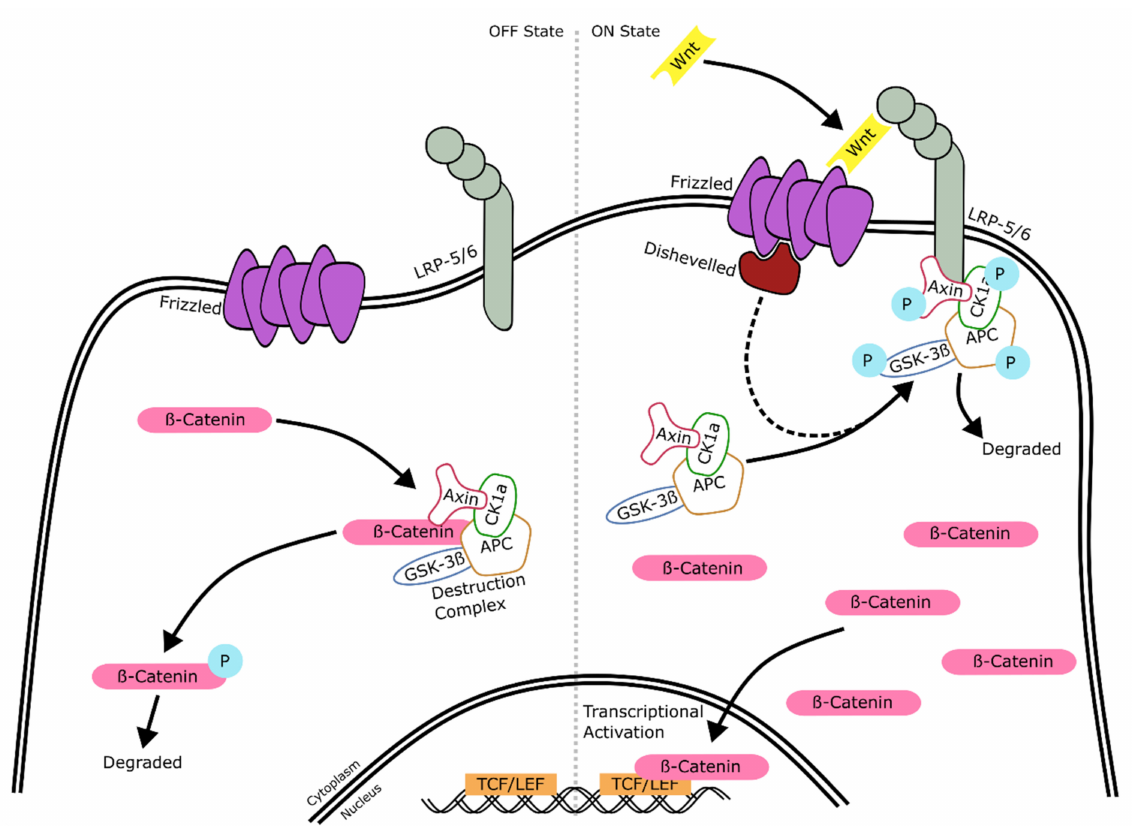
Figure 5. The canonical Wnt signaling pathway. ( Left ) Cells not activated by Wnt signaling exist in an “OFF state”. In the “OFF State” a so-called destruction complex is formed, comprised of Axin, CK1 α , APC and GSK-3 β . The complex phosphorylates (P) β -Catenin, which leads to its degradation. ( Right ) Wnt binds to the cell membrane receptor Frizzled (Fz), which turns the cell into an “ON State”. Frizzled then forms a complex with LRP-5/-6, which results in the recruitment of Disheveled (Dsh), a phosphoprotein. Dsh interacts with the destruction complex and translocates it to the membrane. Here, Axin binds to LRP-5/-6 and the destruction complex is degraded. This allows β -Catenin to accumulate in the cytoplasm and subsequently enter the nucleus, where it activates transcription of the